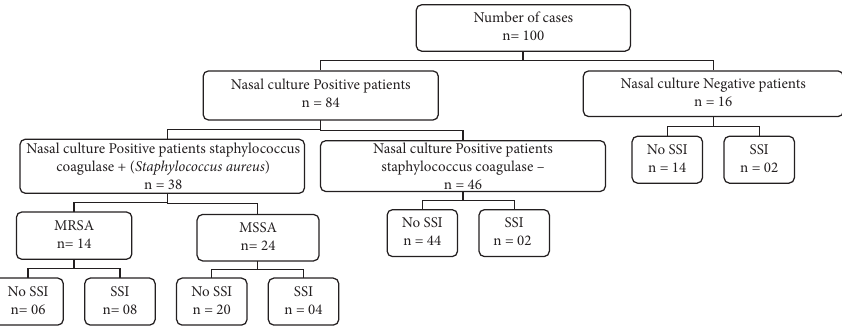
Figure 1: Flowchart of patient distribution according to Staphylococcus colonization. Table 2: Demographic and clinical characteristics of patients by nasal carriage status of MRSA and MSSA ( N � 38). Demographic and clinical characteristics of